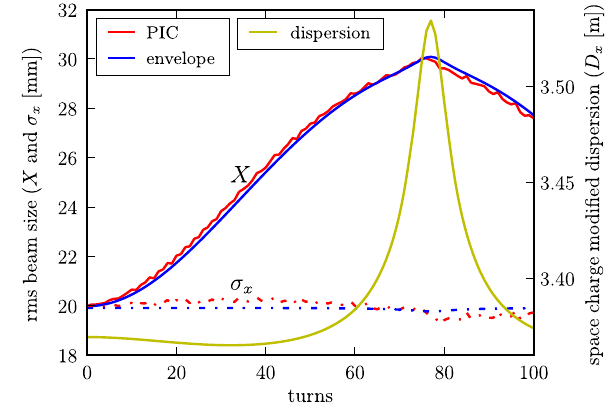
FIG. 5. Evolution of the total rms beam size X , the betatron beam size σ , and the space-charge-modified dispersion D x during bunch compression obtained from PIC simulation and envelope